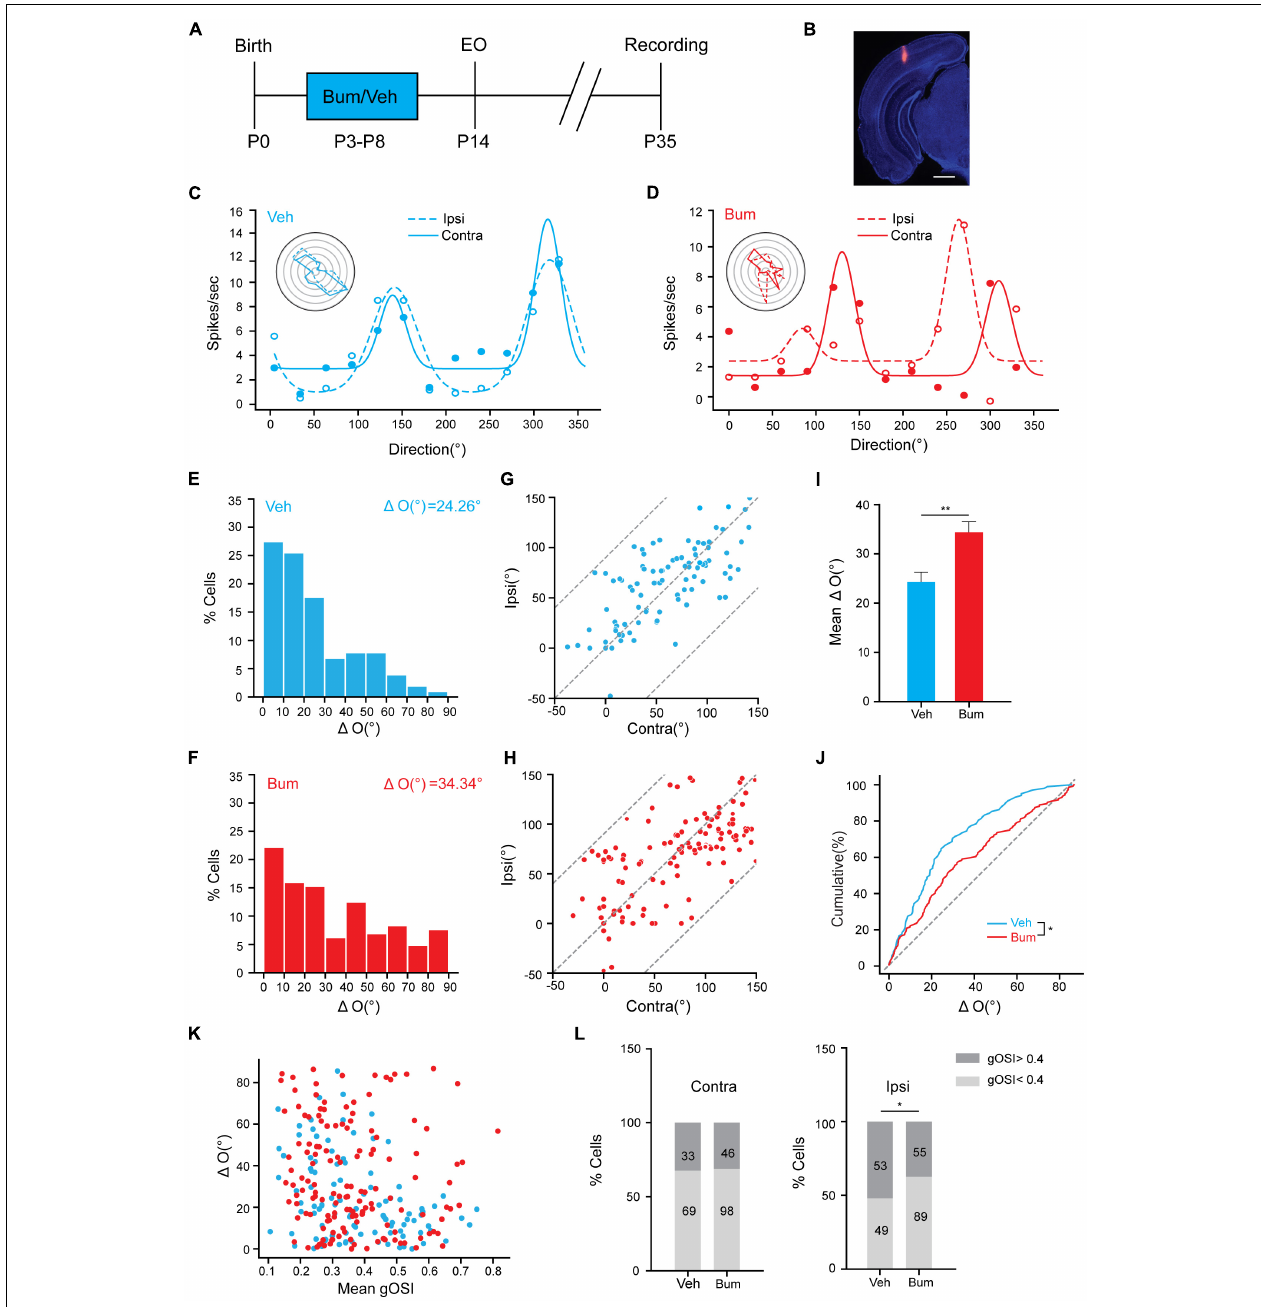
FIGURE 2 | Binocular matching of orientation preference is impaired in Bum mice at P35. (A) Experimental paradigm. (B) Image showing traces of electrode in V1b. Red indicates electrode traces. Scale bar, 500 µ m. (C,D) Orientation tuning curves of a visually responsive unit for (C) Veh and (D) Bum mice. Representative polar plots of orientation-tuned responses from contralateral (solid line) and ipsilateral (dashed line) eye are depicted. (E,F) Distribution of difference in preferred orientations through the two eyes in (E) Veh ( (cid:49) O = 24.26 ± 1.54 ◦ ) and (F) Bum ( (cid:49) O = 34.34 ± 2.15 ◦ ) mice. The data were binned at 10 ◦ from 0 to 90 ◦ . (G,H) Correlation of orientation preference between the two eyes. (G) High correlation binocularly ( r = 0.69, p < 0.0001, 102 cells, 10 mice) in Veh mice at P35, with most points cluster close to the unity line. The dotted lines bound the region in which the data points can lie. (H) Correlation ( r = 0.51, p < 0.0001, 142 cells, 14 mice) is low in Bum mice with respect to Veh group. (I) Mean (cid:49) O is significantly higher in Bum than Veh animals ( p = 0.0035, Mann-Whitney rank-sum test) at P35. (J) Cumulative distribution of (cid:49) O for Bum and Veh mice at P35 ( p = 0.014, K-S test). The (cid:49) O distribution of random matching (dotted gray line) is shown for comparison. (K) Scatter plots of (cid:49) O as function of orientation selectivity for individual cells (mean gOSI of the monocular tuning curves) for Veh (blue, r = 0.69, p = 1.06 × 10 − 15 ) and Bum mice (red, r = 0.51, p = 5.05 × 10 − 11 ). (L) The proportion of cells with high orientation selectivity and low orientation selectivity in the ipsilateral (right) ( χ 2 -test, p < 0.05) or contralateral (left) eye, respectively, in Veh and Bum animals (dark gray: high selectivity gOSI > 0.4; light gray: low selectivity gOSI < 0.4). Data were expressed as mean ± SEM. *p < 0.05, ** p < 0.01.